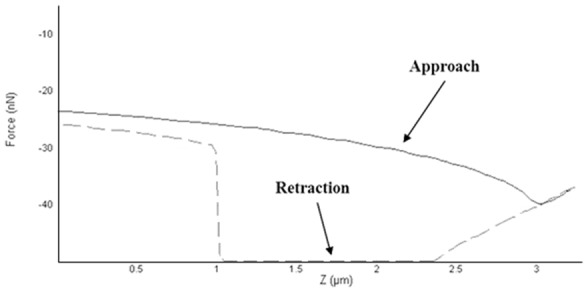
AFM force-distance curve for theophylline.The approaching component shows a noticeable pulling effect while retraction component shows a sticking effect of the probe particle to the particle on the plate (for comparison refer to Fig 1a for a typical force-distance curve).